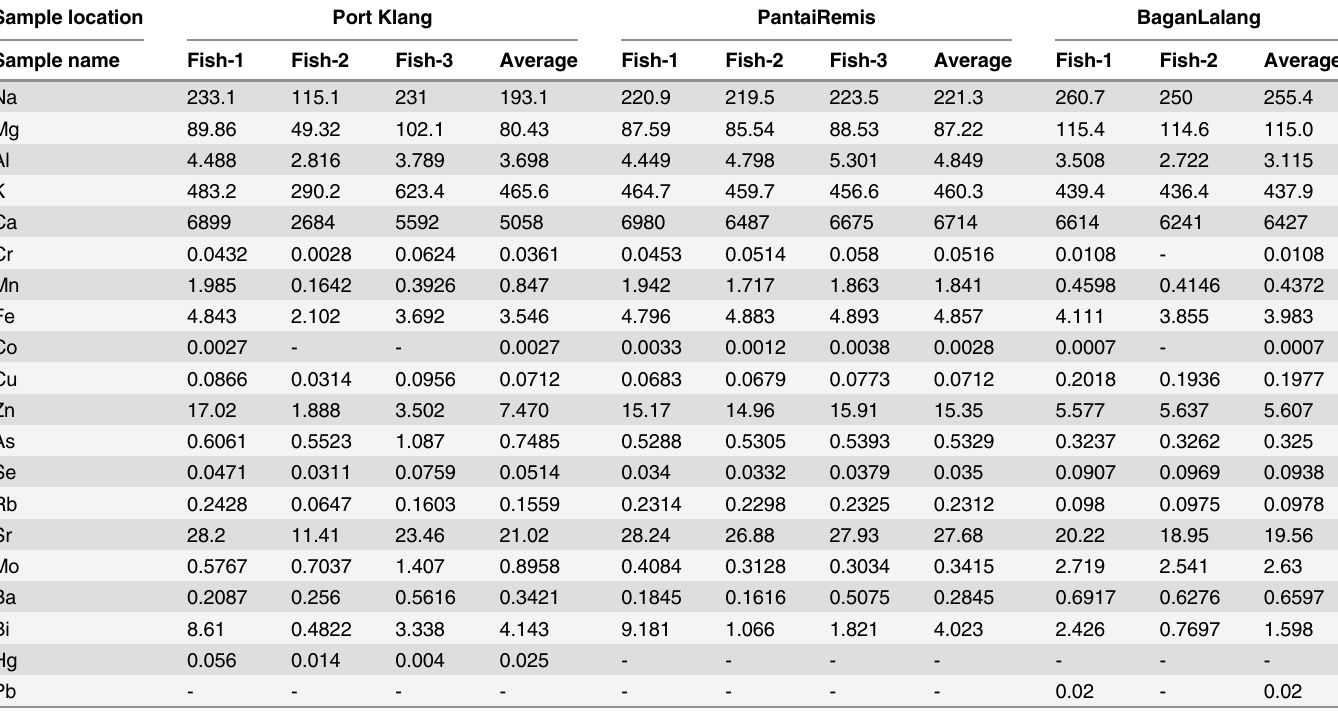
Table 5. Trace element concentrations (mg kg -1 ) in the most frequently consumed sea fish (Ikan Kembung) in Malaysia. Sample